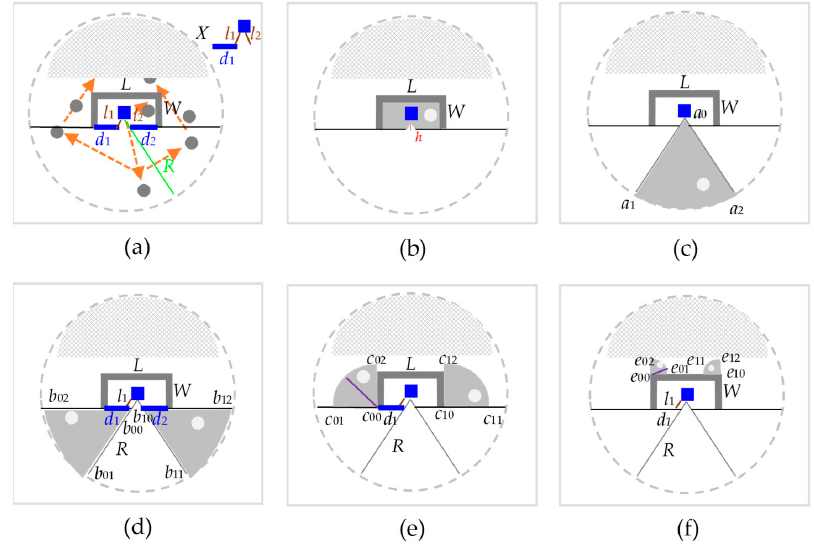
Figure 9. n -shaped layout with a door. ( a ) Radiation of power density distribution. ( b ) Local, ( c ) direct, ( d ) semidirect, ( e ) indirect, and ( f ) subindirect effects.